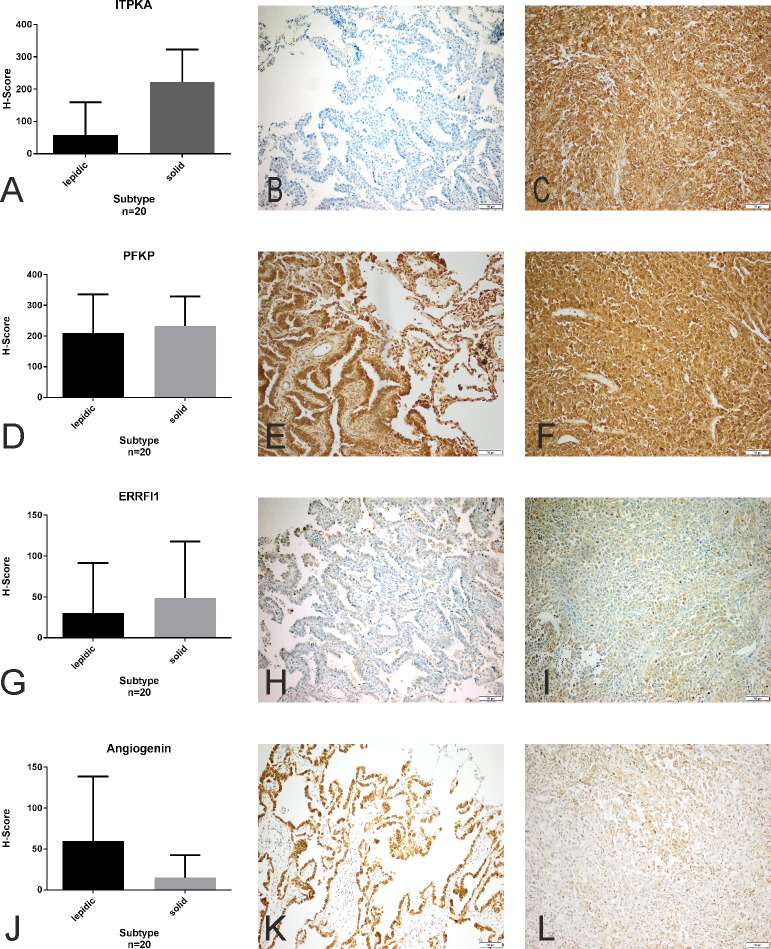
Immunohistochemistry.Immunohistochemical staining of inositol-1,4,5-trisphosphate-3-kinase-A (ITPKA), phosphofructokinase, platelet (PFKP), mitogen-inducible gene 6 (ERRFI1) and angiogenin (ANG) in pulmonary adenocarcinoma with predominant lepidic (B, E, H, K) and solid growth patterns (C, F, I, L). 200x magnification. Histograms depict mean staining scores with standard deviation of n = 20 adenocarcinomas each (A, D, G, J).